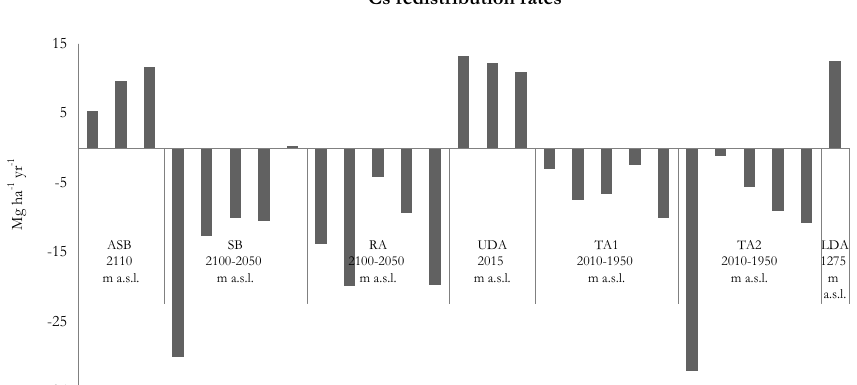
Fig. 7. Soil redistribution rates in all the sampling sites: Snow Bridge area (SB); Above Snow Bridge area (ASB), Release Area (RA); Upper Deposition Area (UDA), Track Area (TA), Lower Deposition Area (LDA). Negative values indicate erosion, while positive ones indicate accumulation. In each transect (SB, RA and TA) the first point in the graph is at highest elevation while the fifth is at lowest elevation.